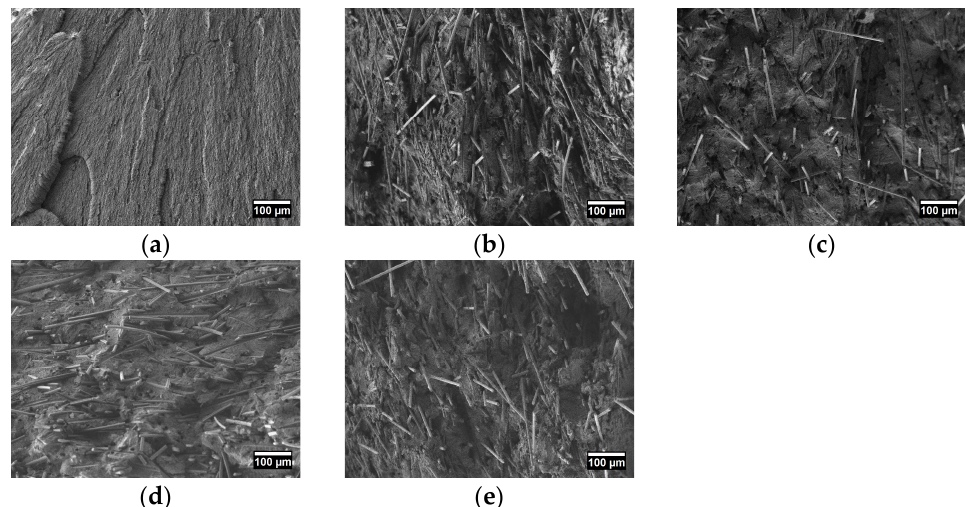
Figure 4. SEM image of microstructures of the initial PTFE and PCM: ( a ) initial PTFE; ( b ) PTFE/CF/SiO 2 ; ( c ) PTFE/CF/ZrO 2 ; ( d ) PTFE/CF/SiO 2 /BN; ( e ) PTFE/CF/ZrO 2 /BN.